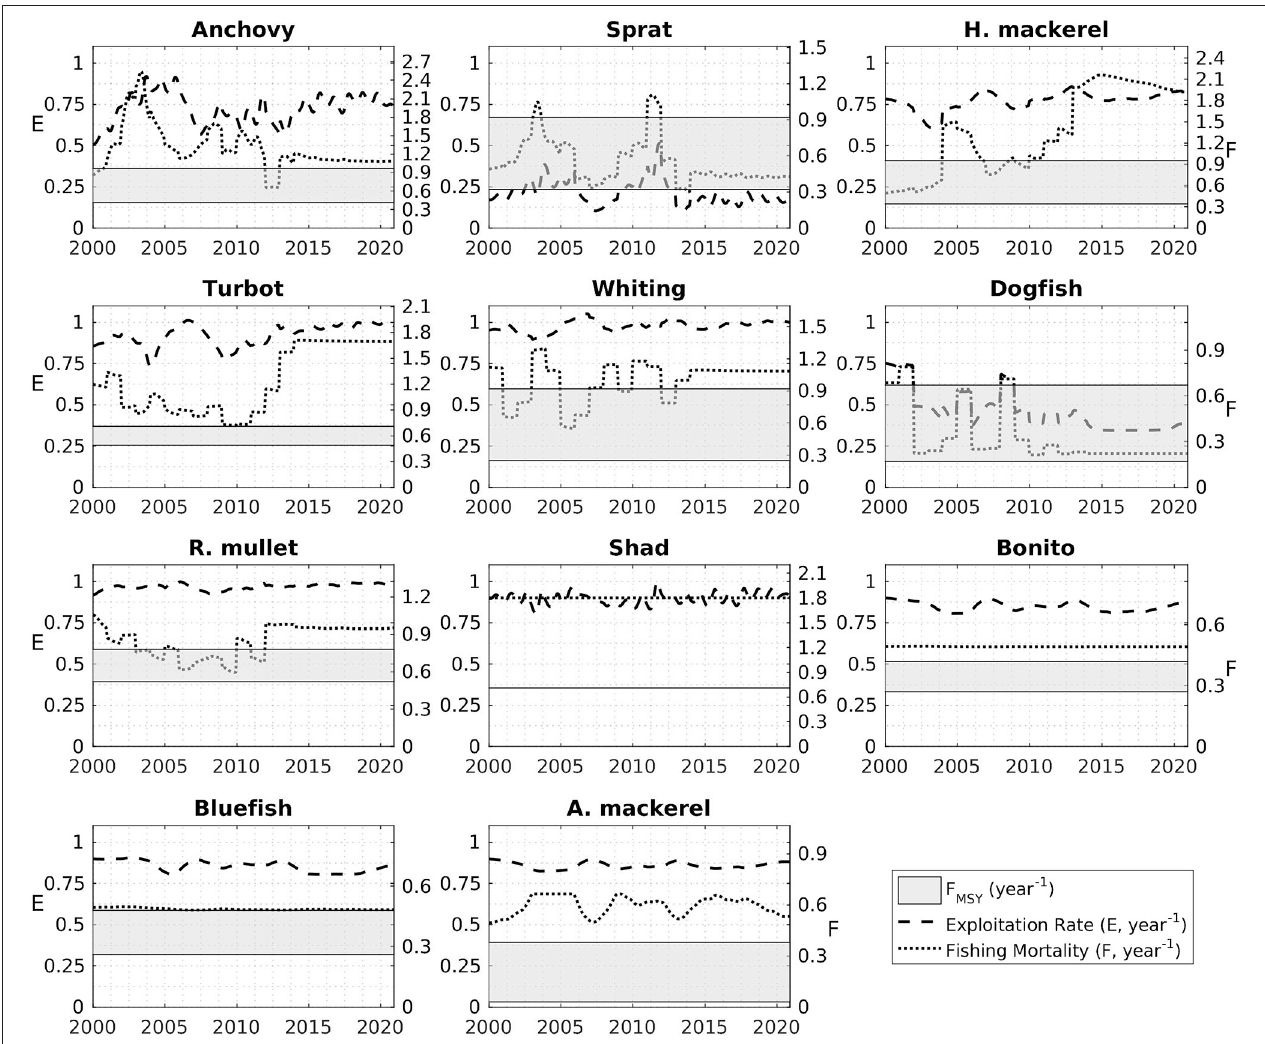
FIGURE 13 | Exploitation rates (E, dashed line) and fishing mortalities (F, dotted line) for the modeled fish groups during the hindcast (2000–2014) and forecast (2015–2020) simulation periods. The gray shaded areas denote the range bounded by the minimum and maximum values of F MSY predicted by the model.